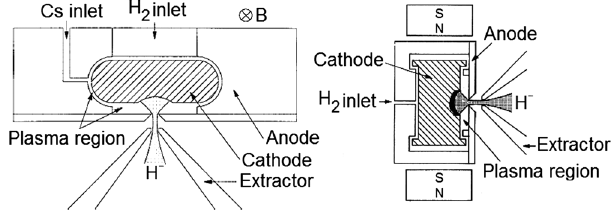
FIG. 1. Schematic of Fermilab ’ s magnetron H −